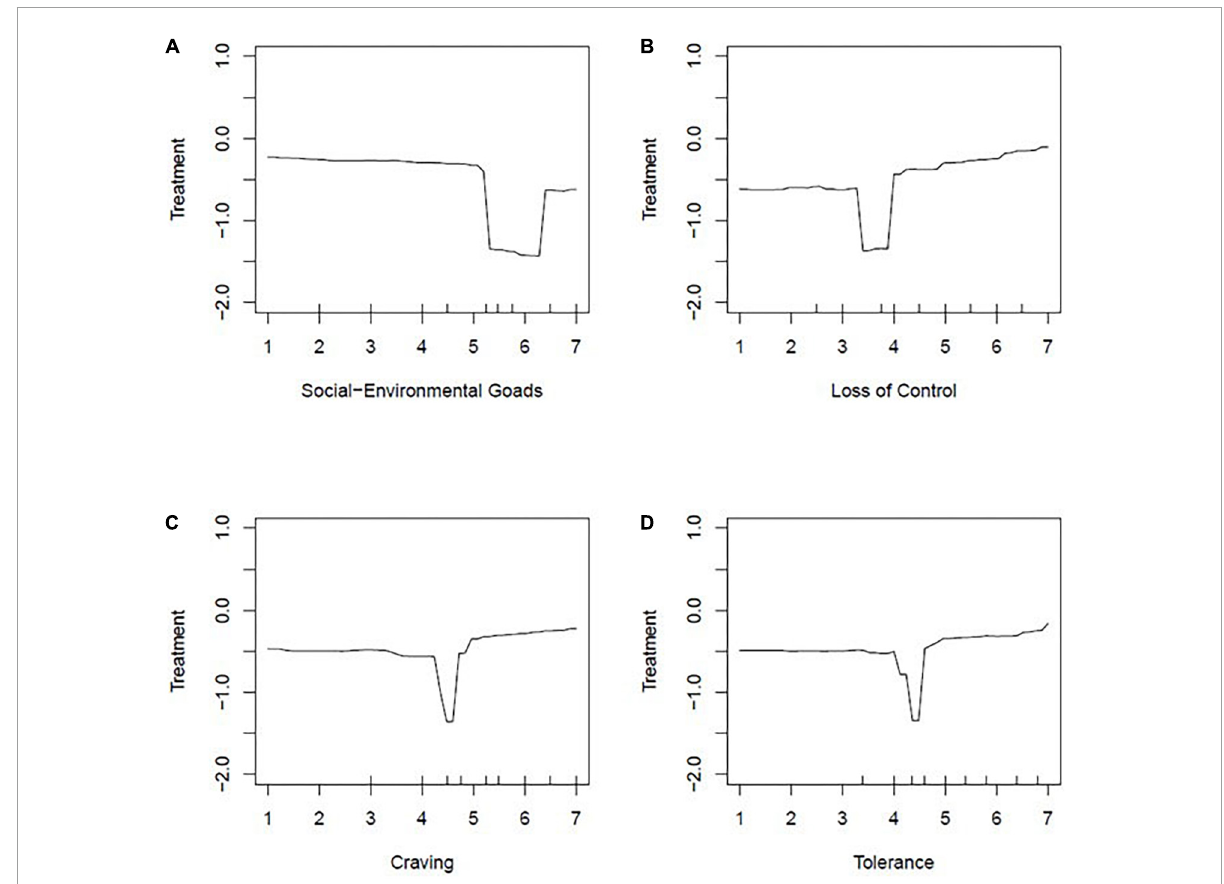
FIGURE3 Partial dependence plots: Four of the WISDM-68 subscales: (A) Social environmental goads, (B) loss of control, (C) craving, (D) tolerance. Partial dependent plots are displayed to show the effect of 4 WISDM-Subscales (social environmental goads, loss of control, craving, tolerance) on the log-odds of treatment seeking